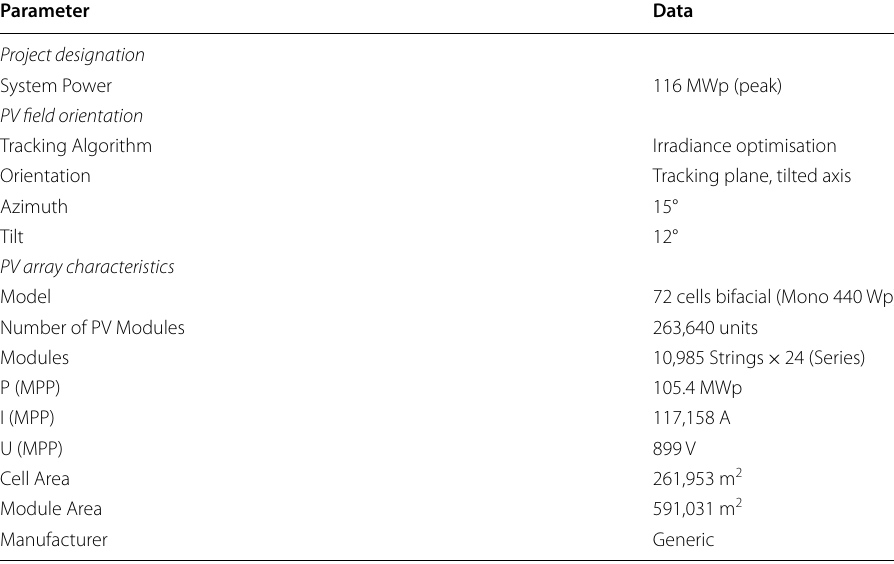
Table 5 Input data of grid-connected PV system design [10, 11]